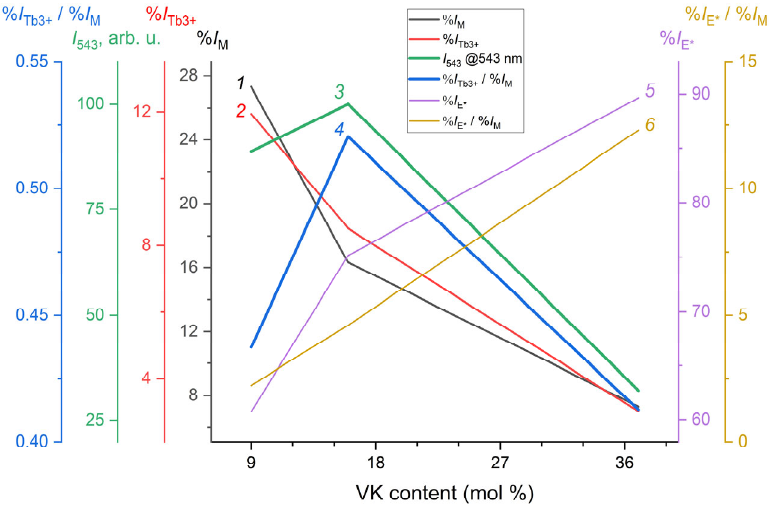
Figure 8. Effect of the poly(VT- co -VK) composition on VK unit luminescence contribution % I M ( 1 ), Tb 3+ luminescence contribution % I Tb(III) (2), Tb 3+ luminescence EET rate % I Tb(III) /% I M ( 3 ), the luminescence intensity of Tb 3+ ions, I 543 ( 4 ), and on excimer contribution % I E* ( 5 ), and excimer EET rate % I E* /% I M ( 6 ). See Table S1 in ESM.